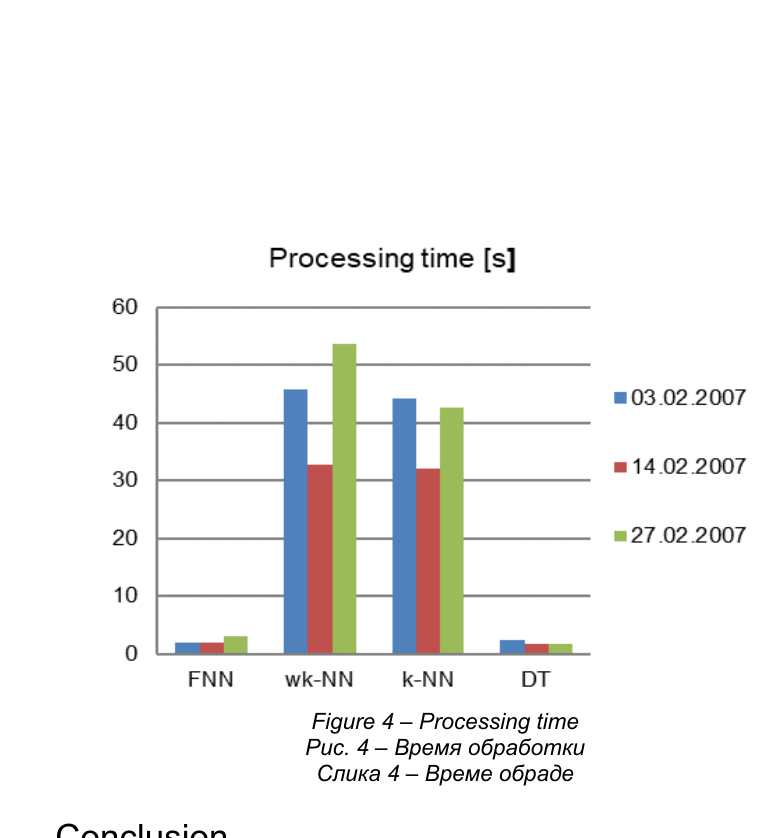
Figure 4 – Processing time Рис . 4 – Время обработки Слика 4 – Време